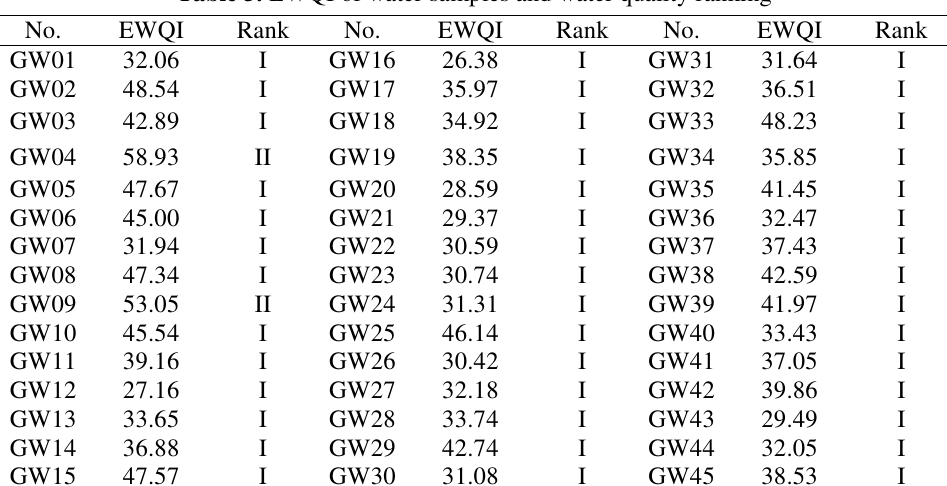
Table 3. EWQI of water samples and water quality